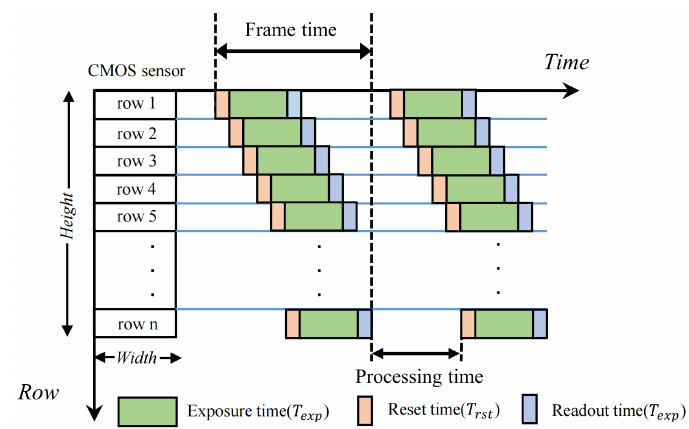
Figure 2. Sketch map of the rolling shutter of the CMOS